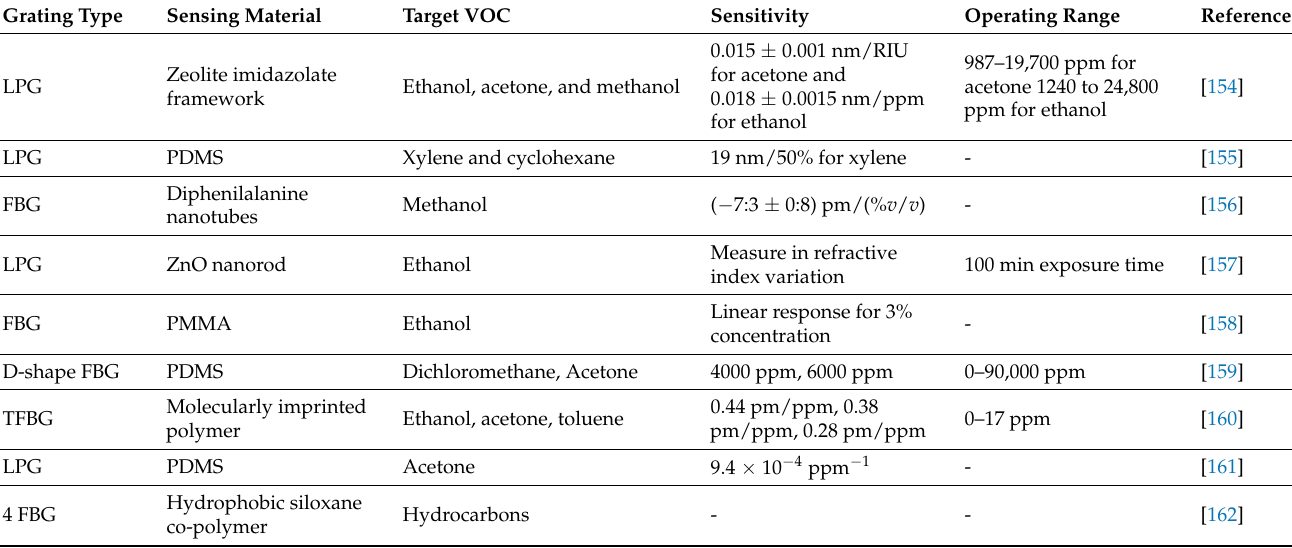
Table 4. Few selective grating-based optical fiber VOC